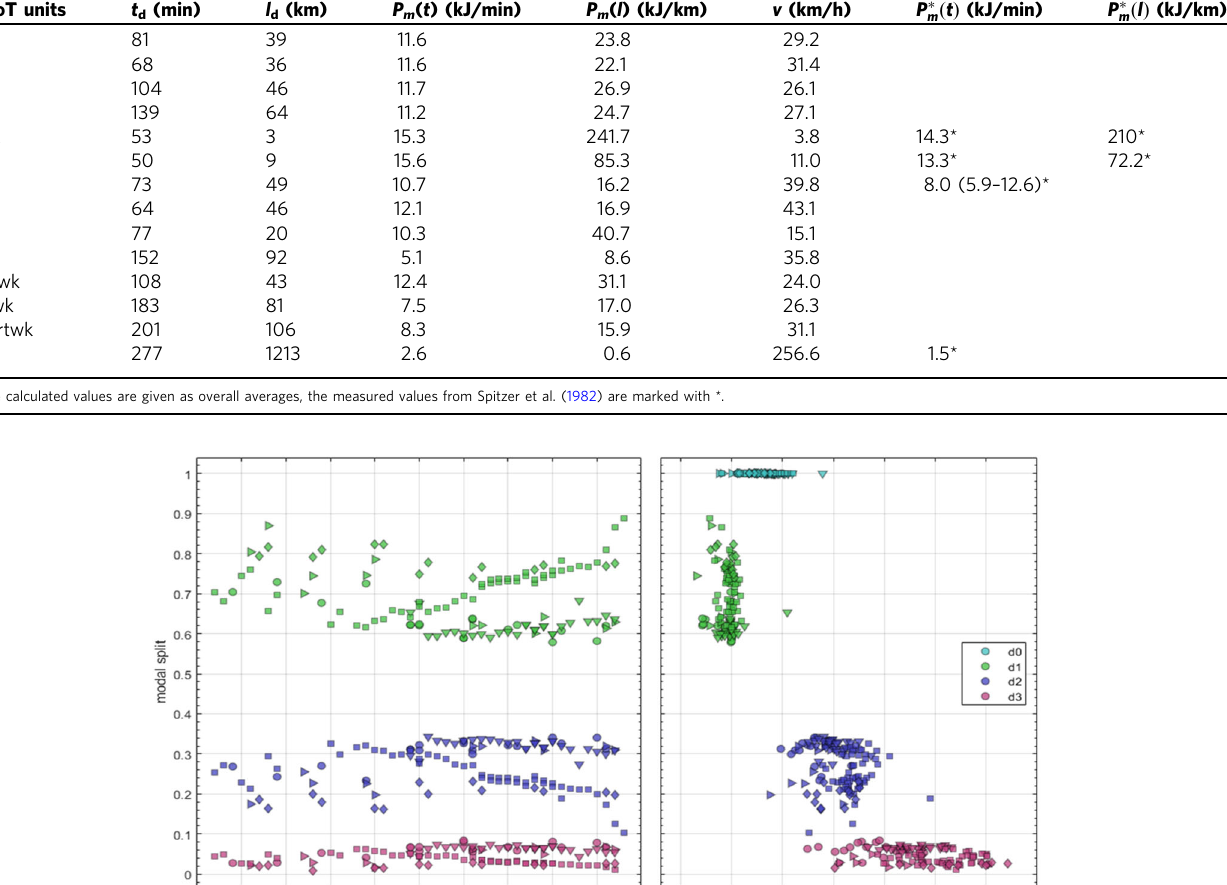
Table 2 Comparison of ground truth, with overall averages of time, distance and speed, calculated and measured power values of selected modes of transport (MoT), nominated as in Fig. 4, including air travel (ar).